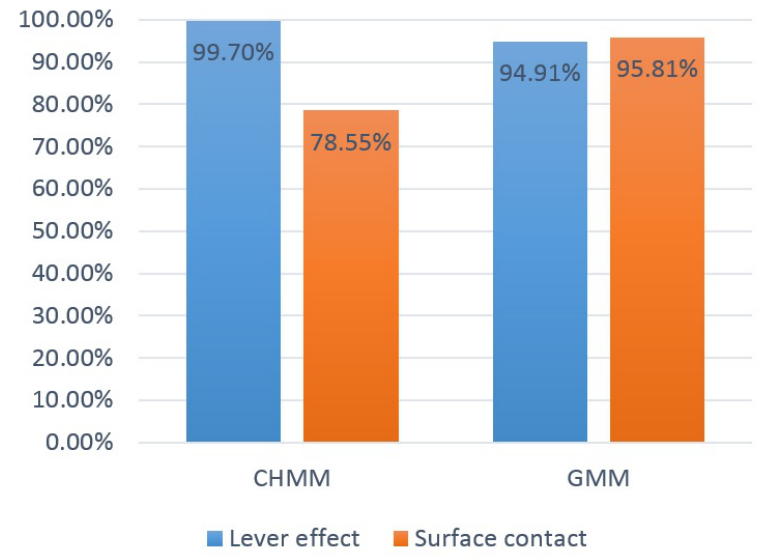
Figure 11. Percentage of real-time recognition using the evaluation movement of both gestures, and both CHMM and GMM